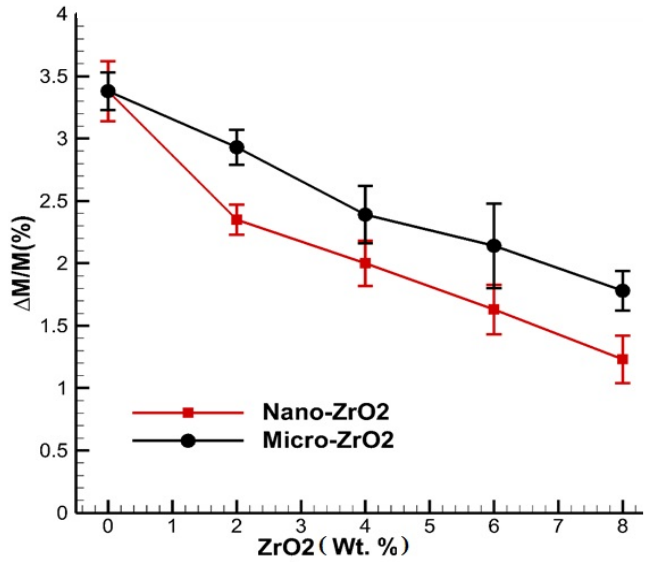
CaO -on improvement of slaking resistance of MgO 2 of ZrO Effect 3 .Fig